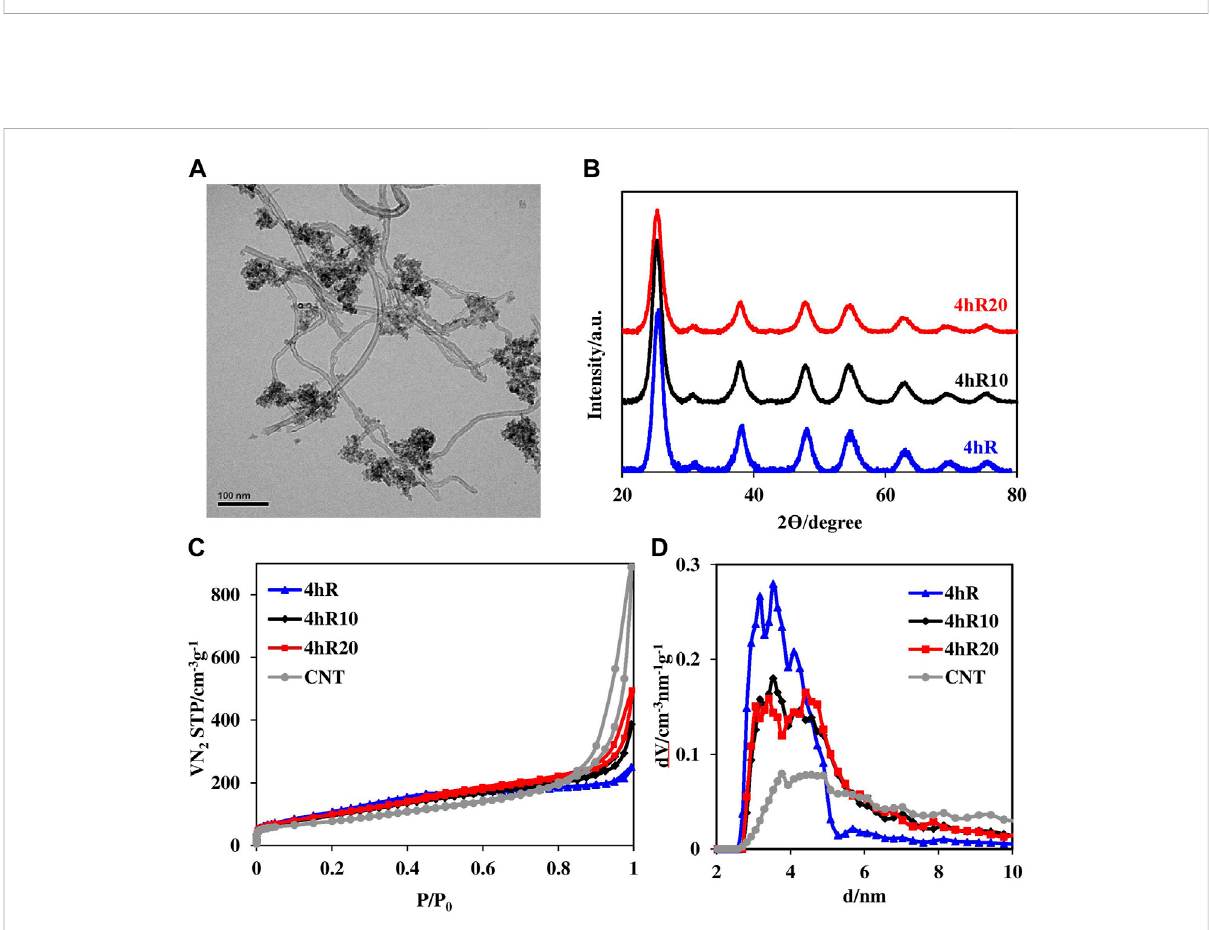
FIGURE 8 (A) TEM image of the 4hR20 TiO 2 /CNT composite. Physicochemical characterization of 4hR TiO 2 and its composites with 10 wt% and 20 wt% CNTs (4hR10 and 4hR20): (B) XRD patterns, (C) N 2 adsorption isotherms and (D) DFT pore size